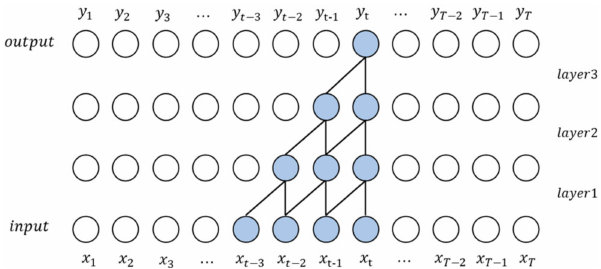
Figure 2. One-dimensional causal